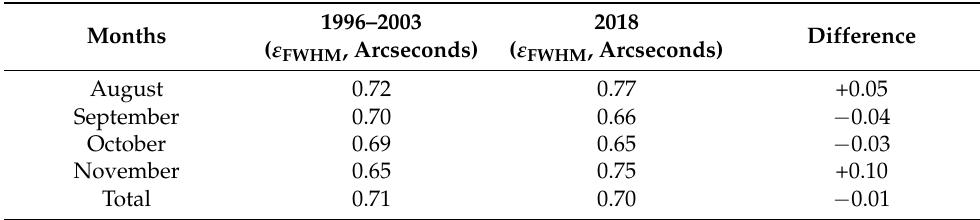
Table 3. Median values of astronomical seeing obtained at the Maidanak Observatory in